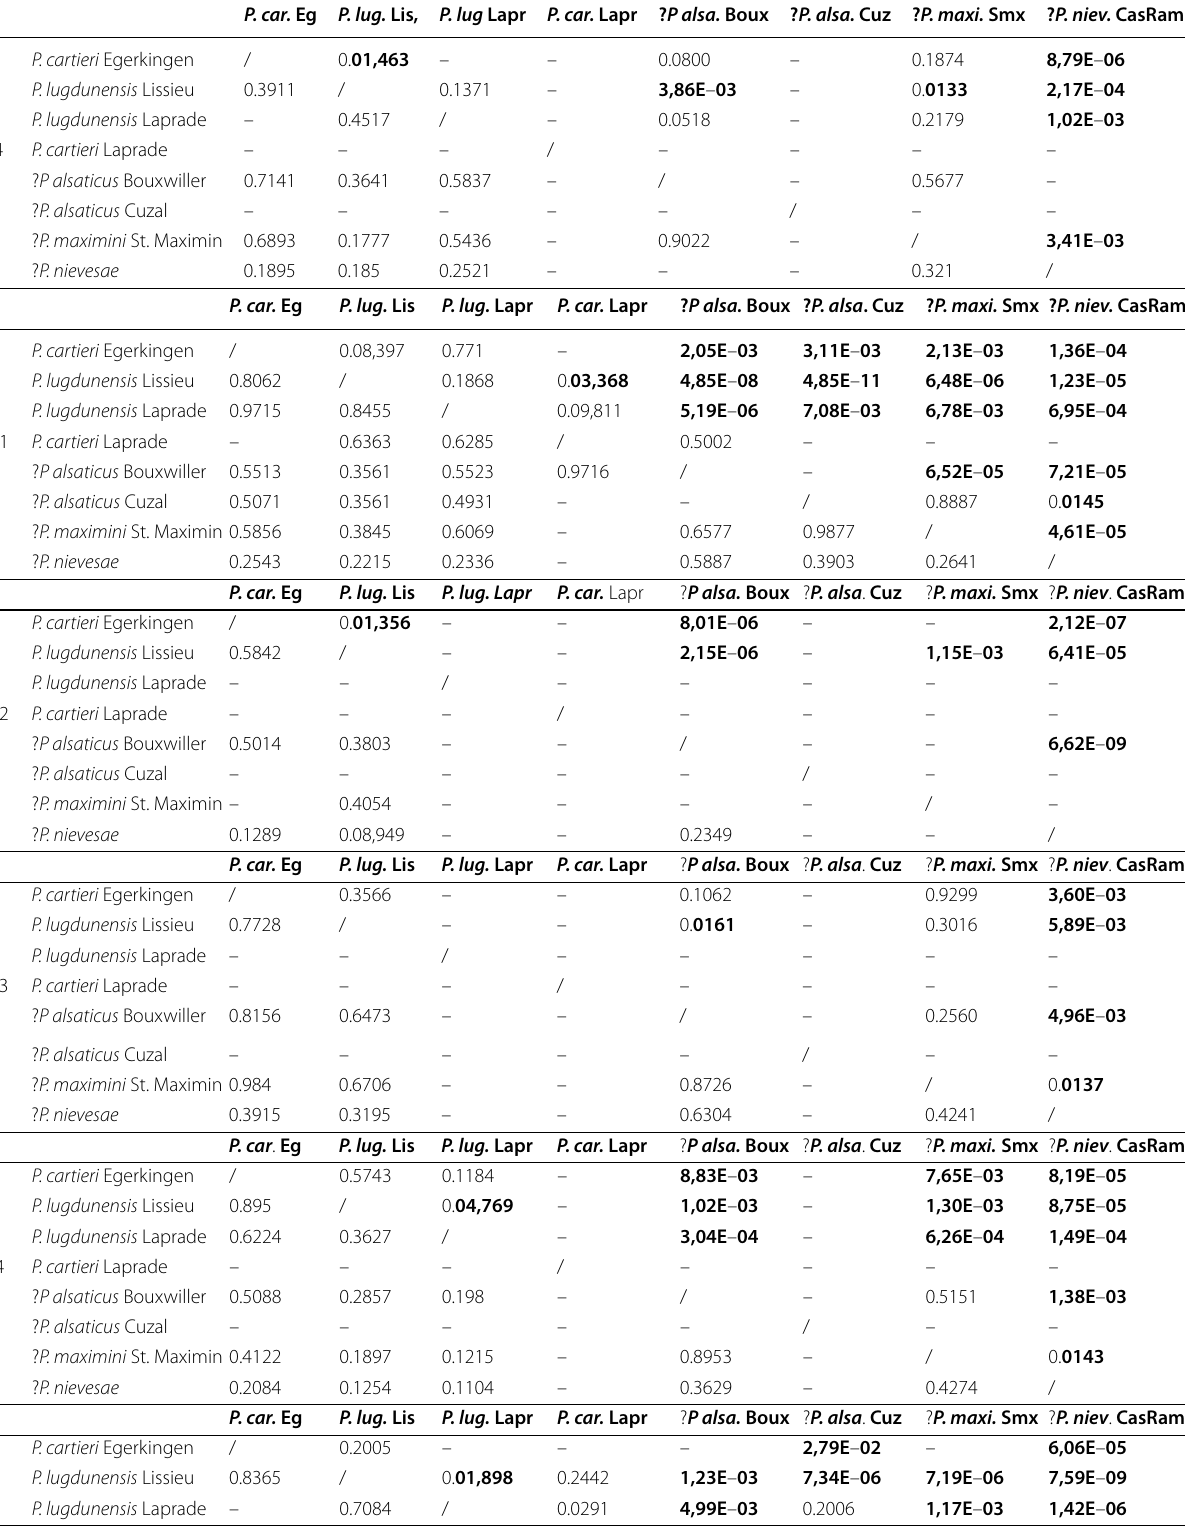
Table 8 Multivariate analyses of variance (MANOVA) of dental measurements (length and width) between different species of Protadelomys and ?